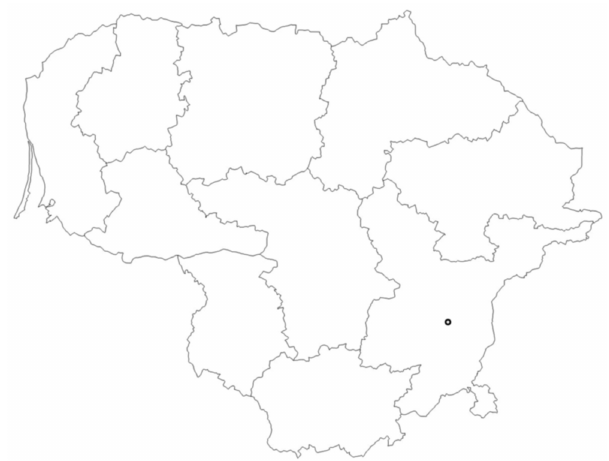
Figure 1. Study area. The circle highlights the capital,